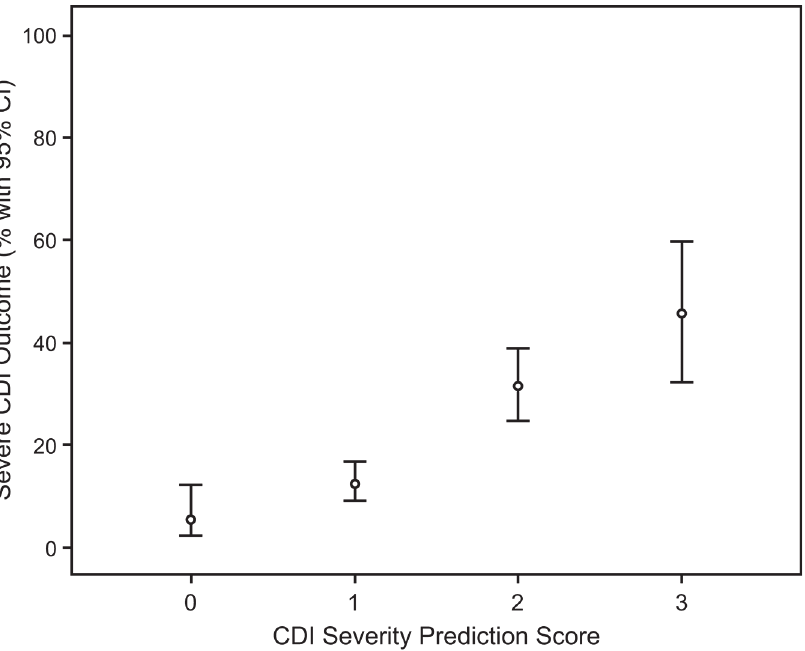
Fig 2. Association between CDI severity prediction score (0 to 3) and severe outcomes of CDI in the entire cohort (n = 596).